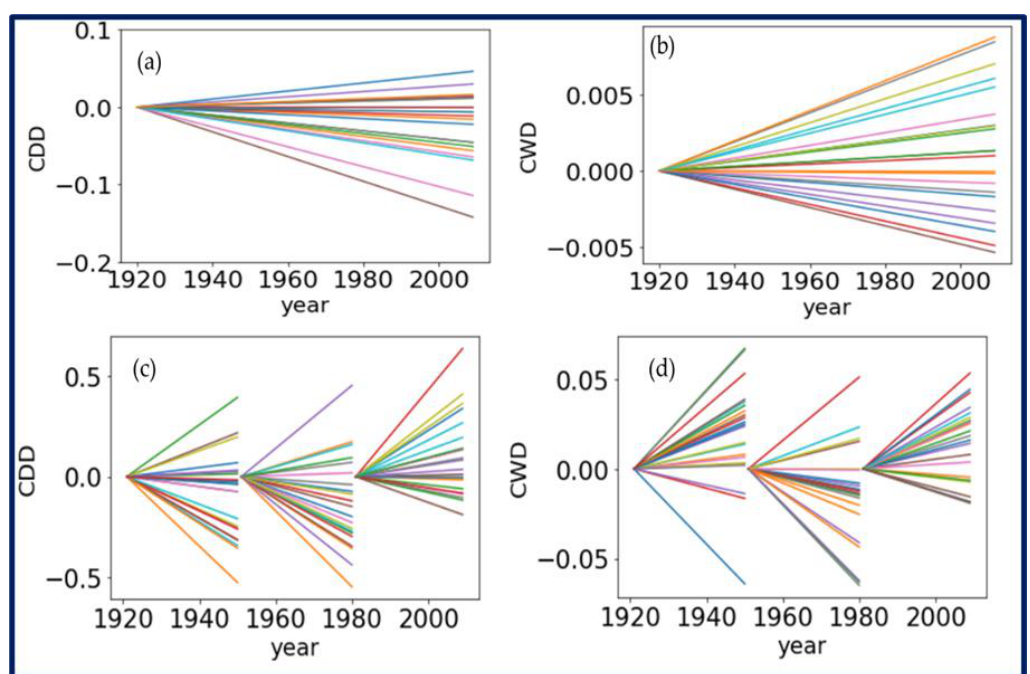
Figure 11. Kansas station trends in the annual consecutive dry days (CDD) between 1980 – 2009 ( a ) and annual consecutive wet days (CWD) ( b ). The data in ( c , d ) is the same as that in ( a , b ), respectively except that it is for the three periods, 1921 – 1950, 1951 – 1980, and 1981 – 2009.